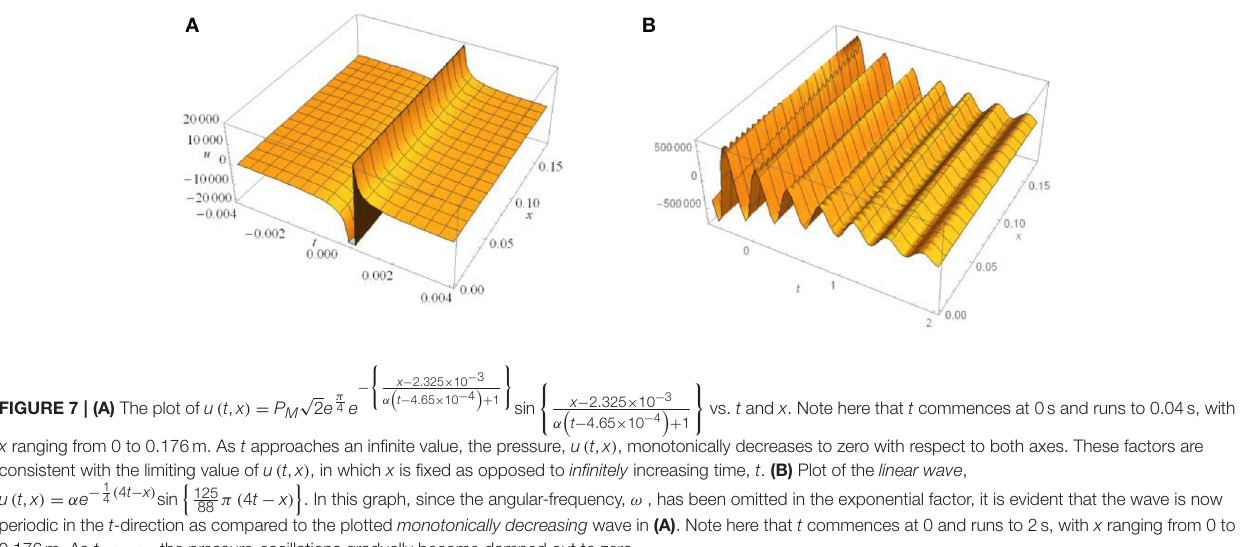
FIGURE 7 | (A) The plot of u ( t , x )